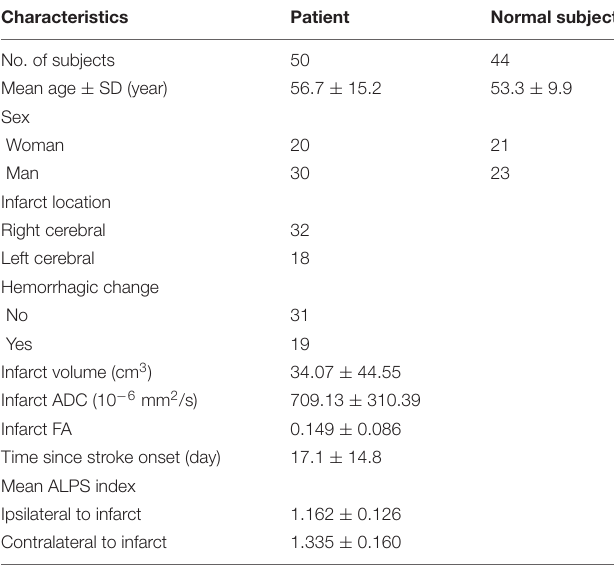
TABLE 1 | Characteristics of patients and normal